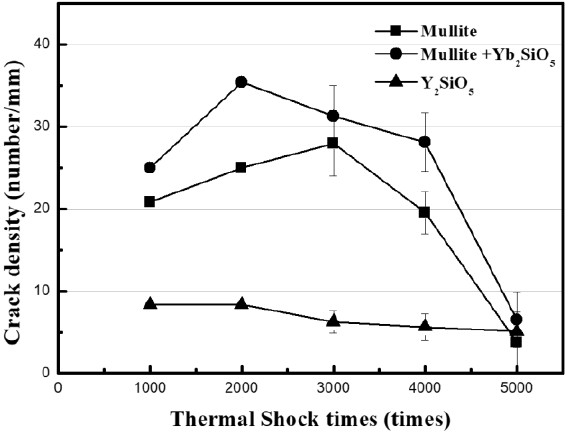
Figure 4. Plot of crack density of EBCs after each 1000 cycles of the thermal shock test at 1350 °C.